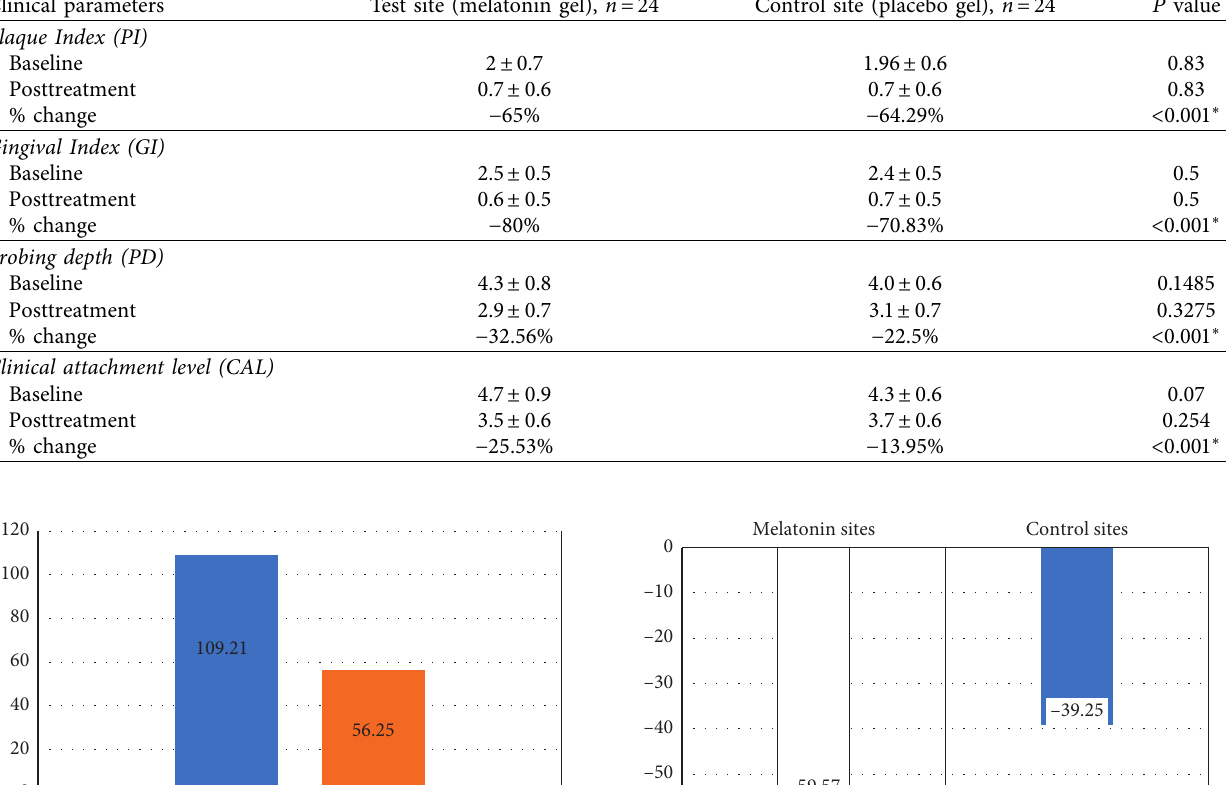
Table 2: Mean and standard deviation values for comparing % changes in all clinical variables among test and control sites. Clinical parameters